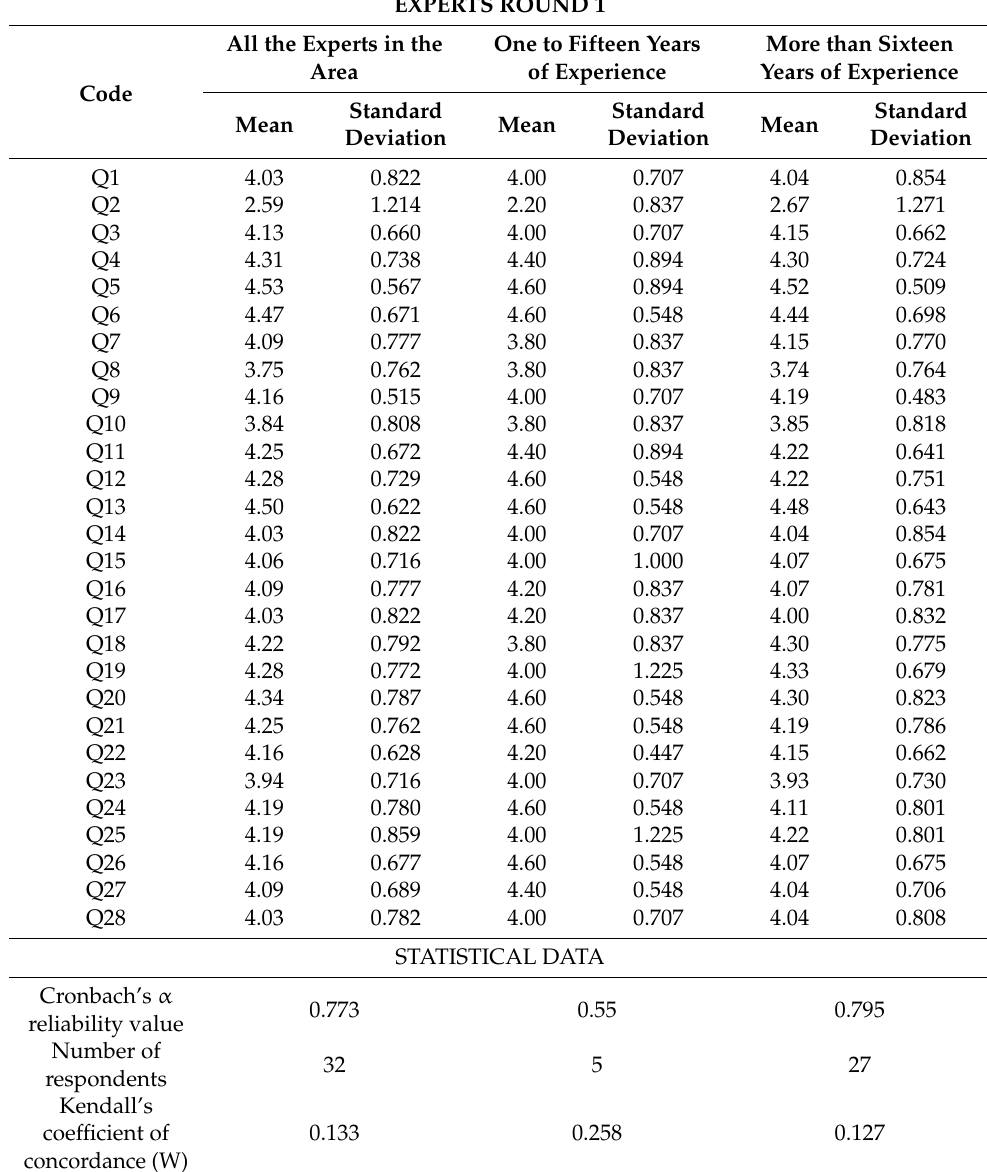
Table 4. 1st round of Delphi survey-BIM integration in steel construction